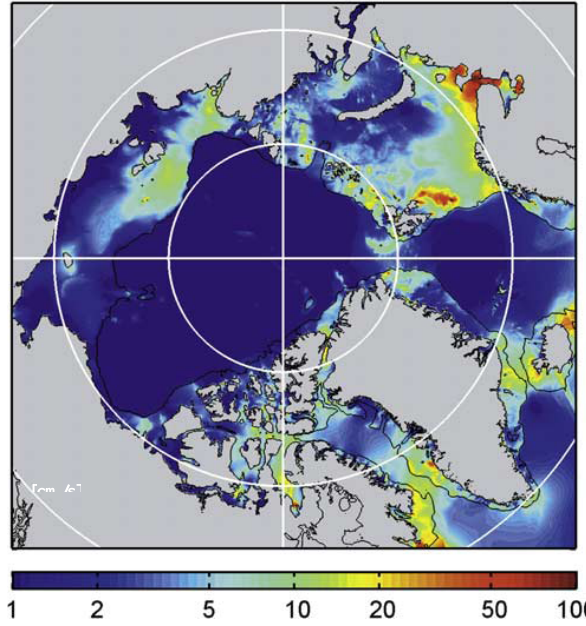
Figure 4. The mean tidal current speed (cm s -1 ) based on the simulation of 14 days of hourly Fig. 4. The mean tidal current speed (cms − 1 ) based on the simu- lation of 14 days of hourly total tidal speed from the 8-constituent total tidal speed from the 8-constituent inverse solution AOTIM inverse solution